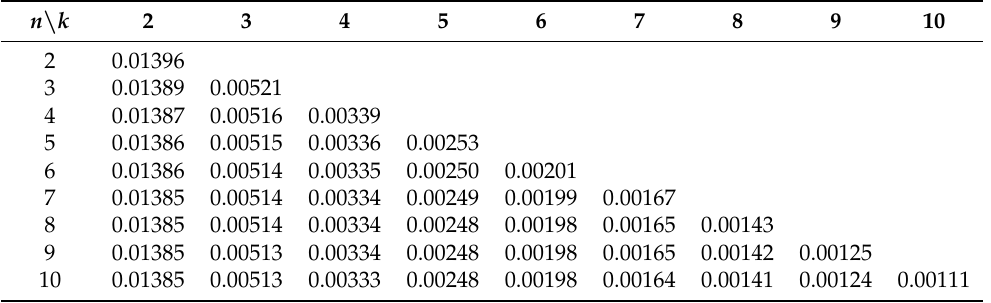
Table 1. Coefficients Γ k n for H = 0.51.